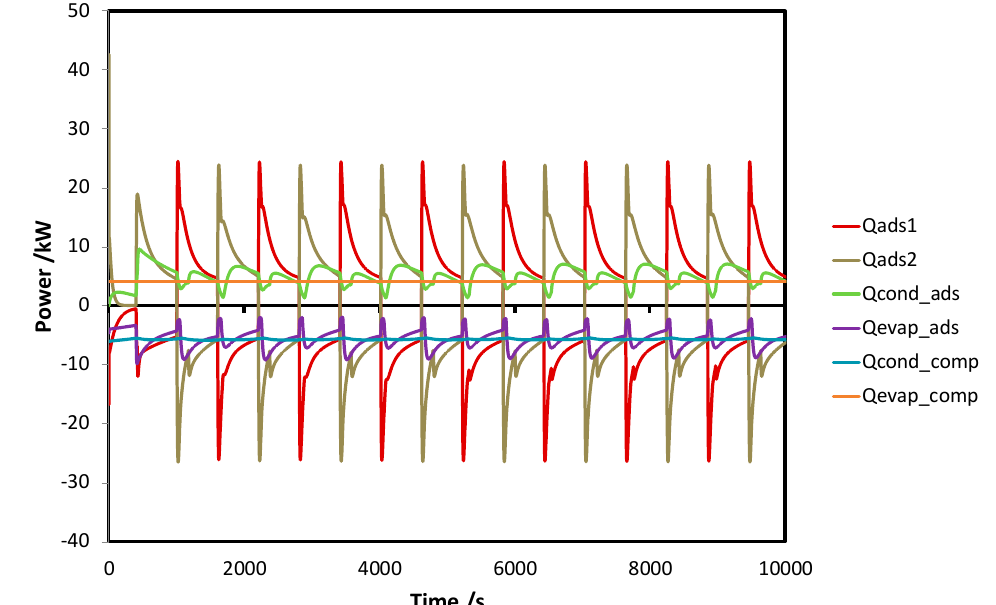
Figure 13. Thermal powers in the components of the sorption module and the vapour compression chiller for the reference conditions.